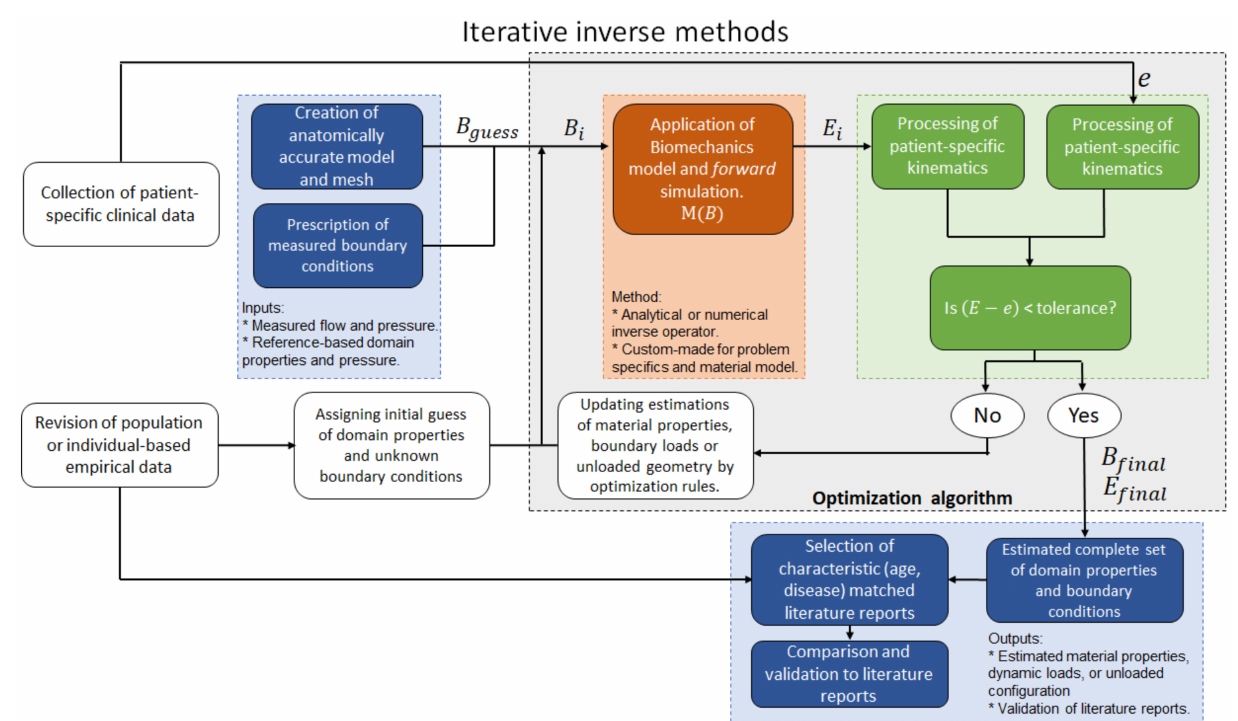
Figure 6. Data processing pipeline for patient-specific iterative inverse methods. Symbols, B : forward problem inputs, E : forward problem outputs, e : experimental